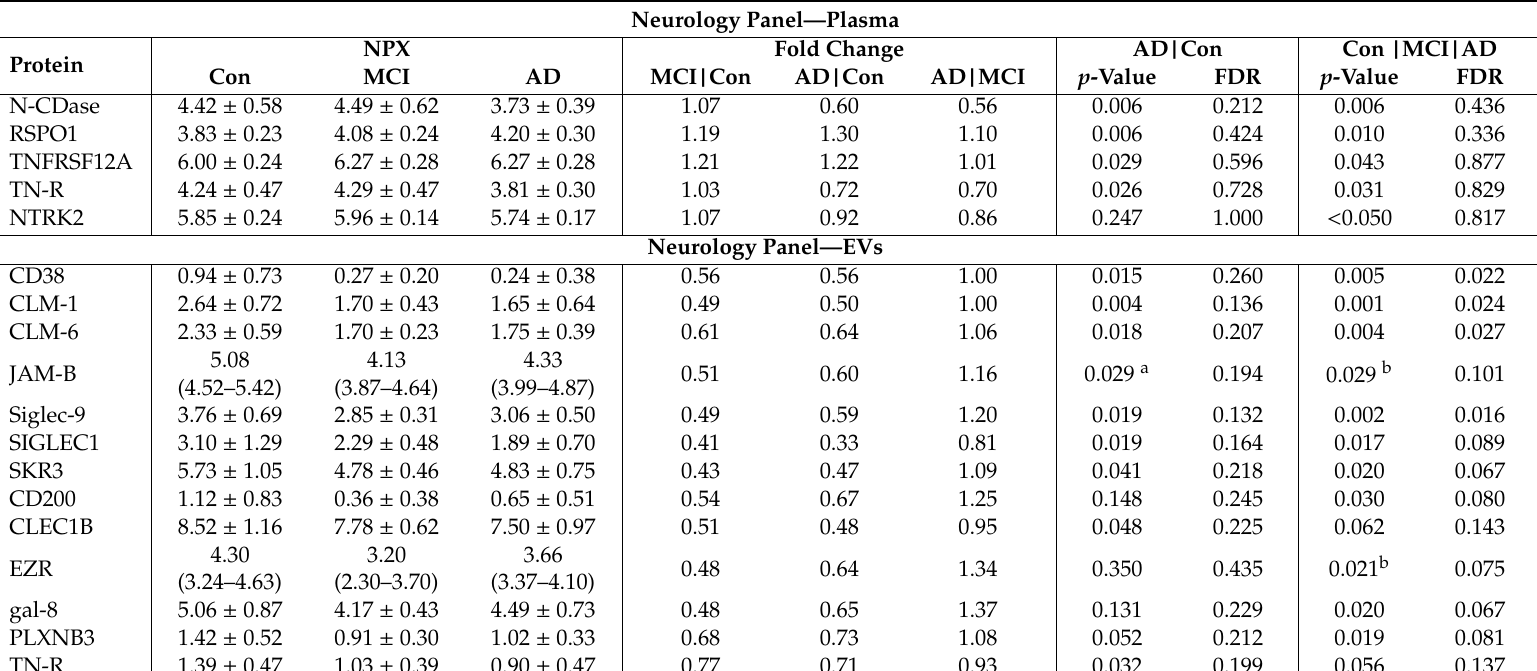
Table 2. Significantly expressed proteins identified from the Neurology panel in plasma and extracellular vesicles. Neurology